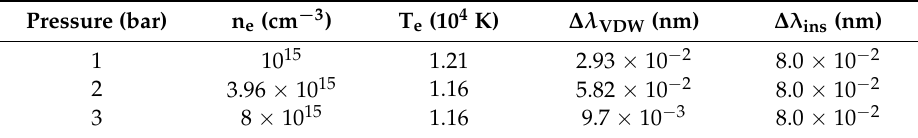
Table 6. Results of the fitting GA analysis of the He I 492 nm